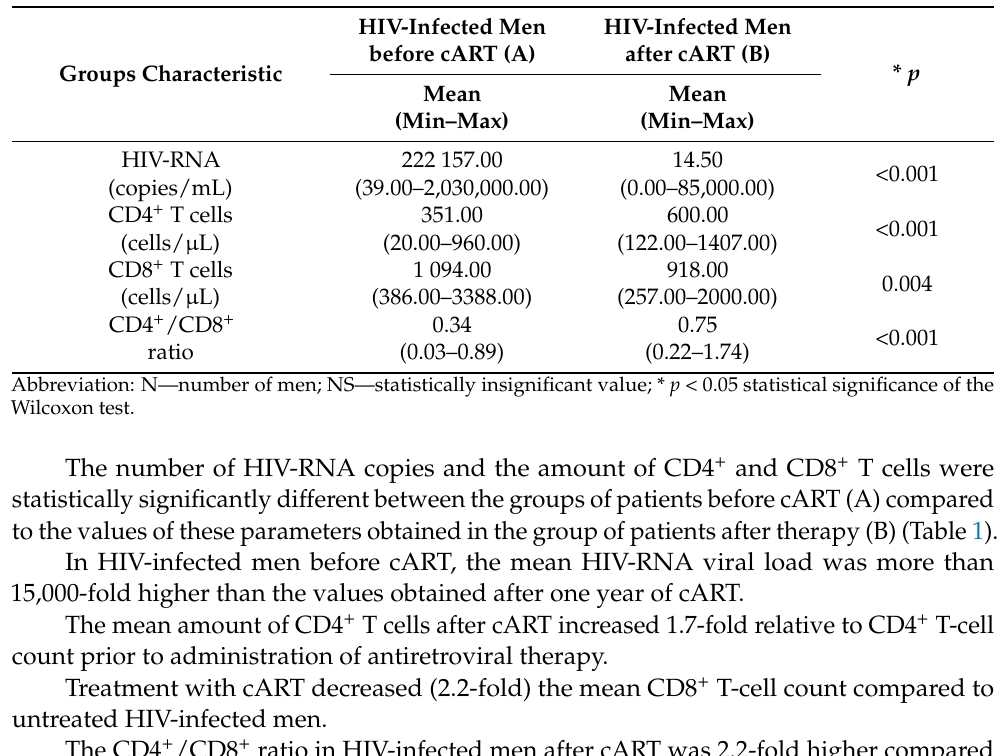
Table 1. Analysis of immunological parameters characterizing HIV-infected men before (A) and after cART (B) depending on the HIV viral load, CD4 + and CD8 + T-cell counts.